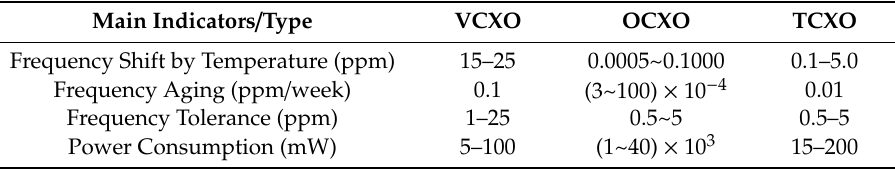
Table 1. Main indicators of the crystal oscillator.